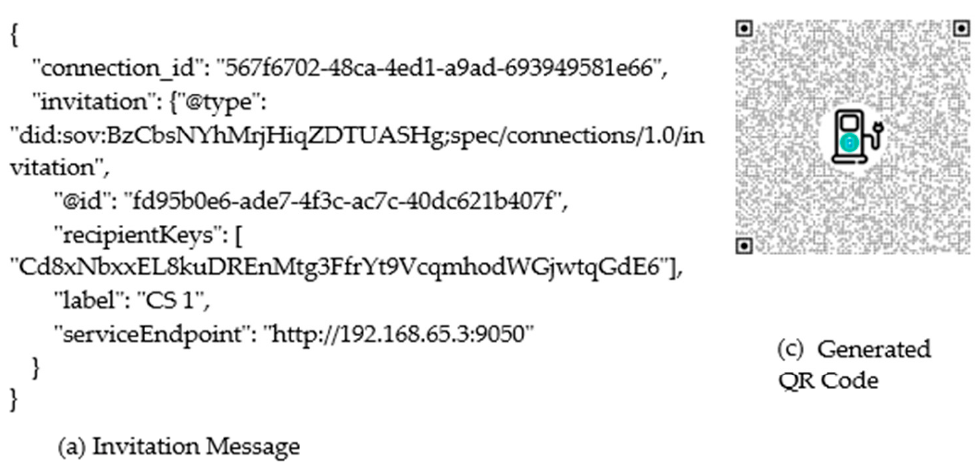
Figure 27. CS invitation to connect message. ( a ) Invitation Message; ( b ) Generated QR Code; ( c ) URI with Encoded invitation.